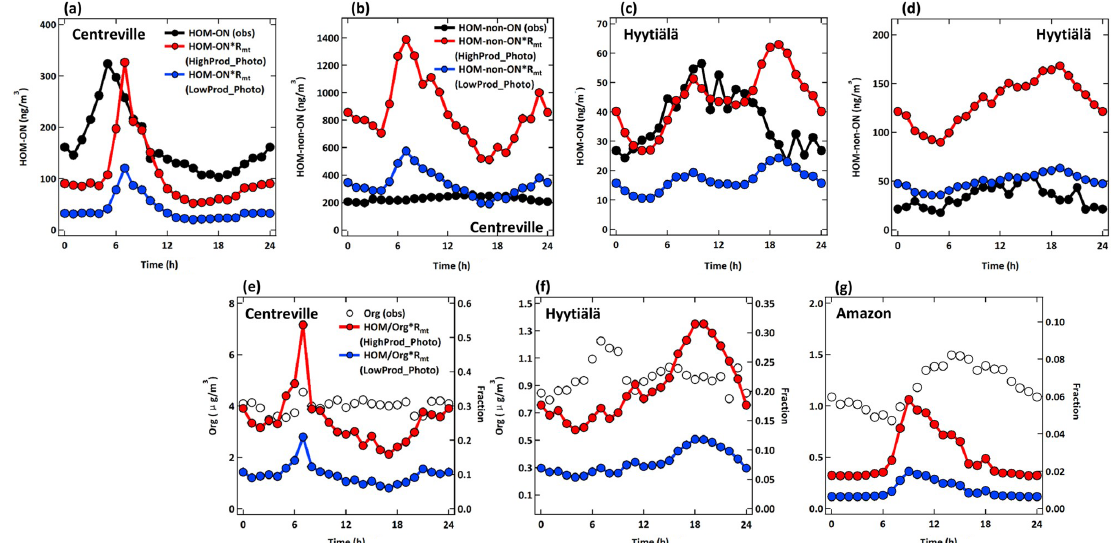
Figure 9. Diurnal changes in observed (black line) and simulated (HighProd_Photo – red line; LowProd_Photo – blue line) (a) HOM-ON and (b) HOM-non-ON mass concentrations at the Centreville site. Panels (c) and (d) are the same as panels (a) and (b) but for the Hyytiälä site. (e–f) Diurnal changes in the observed organic aerosol mass concentrations (black hollow circle markers) and the fractions that simulated total HOMs account for by observed organic aerosols (HighProd_Photo – red; LowProd_Photo – blue) at the Centreville, Hyytiälä, and Amazon sites, respectively.